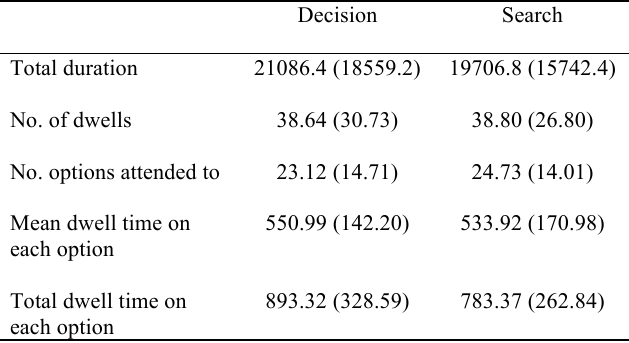
Table 1. Measures of information acquired in the different tasks, SD in